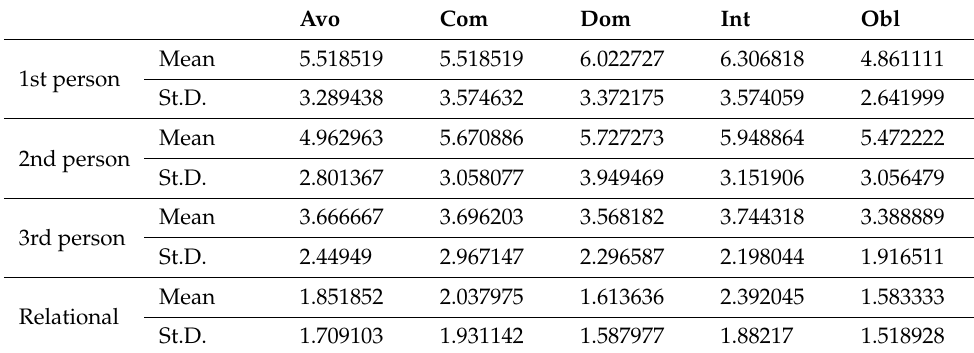
Table 3. Means and standard deviations between the number of personal pronouns and the ROCI-II style class.